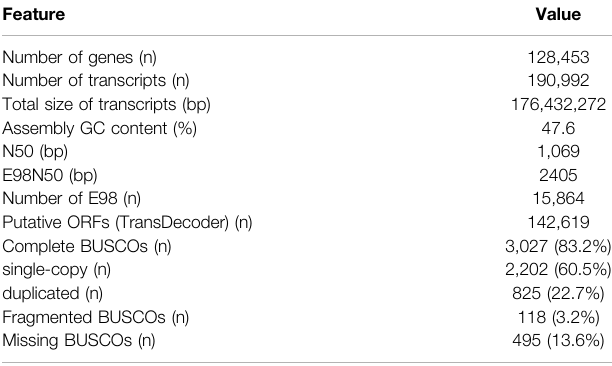
TABLE 2 | Summary statistics of transcriptome assembly Feature